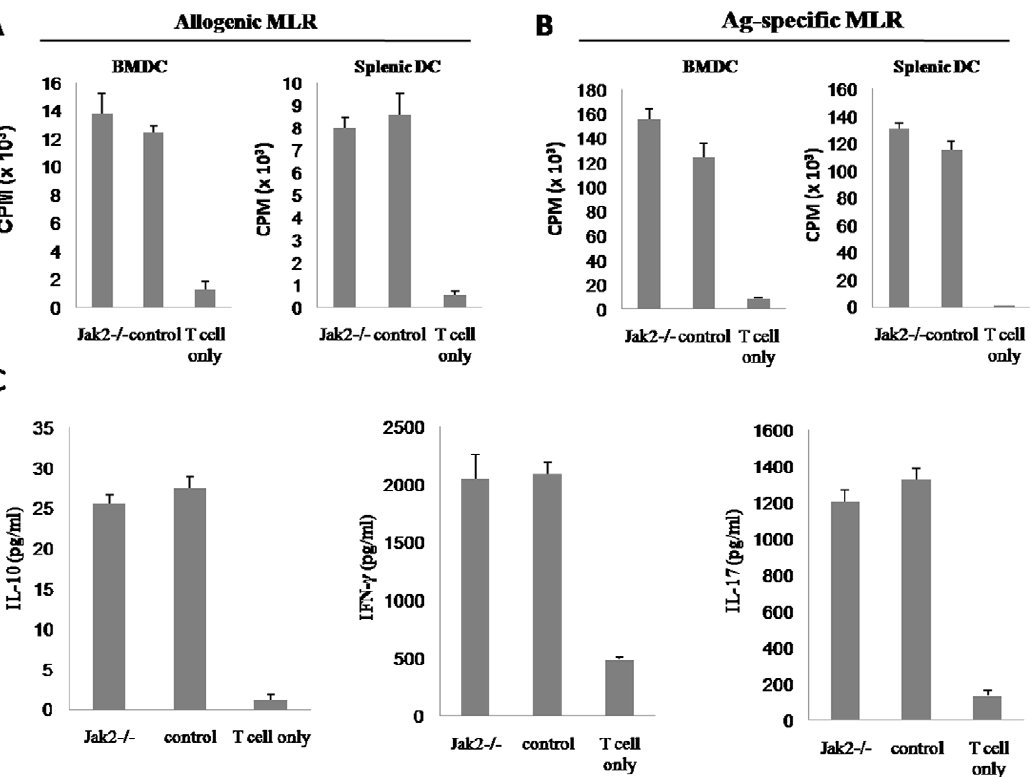
Figure 3. DCs deficient for Jak2 show similar potency to stimulate T cell activation. (A) Allogenic MLR results. (B) Antigen-specific MLR results. (C) ELISA analysis of cytokines produced by the activated T cells. MLR were carried out using either BALB/c T cells (allogenic) or OT-1 T cells (antigen-specific) as responders in the condition of DC/T ratio 1:10. T cell proliferation was estimated by 3 H thymidine incorporation. Data shown in the figure are mean 6 SE of three independent experiments performed.